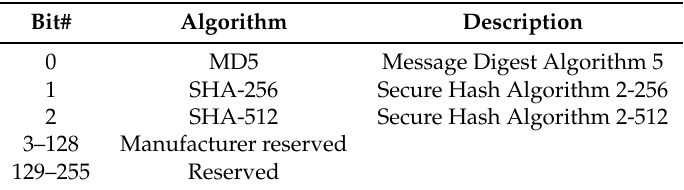
Table 3. IEEE 1451.0 security TEDS used hashing algorithm